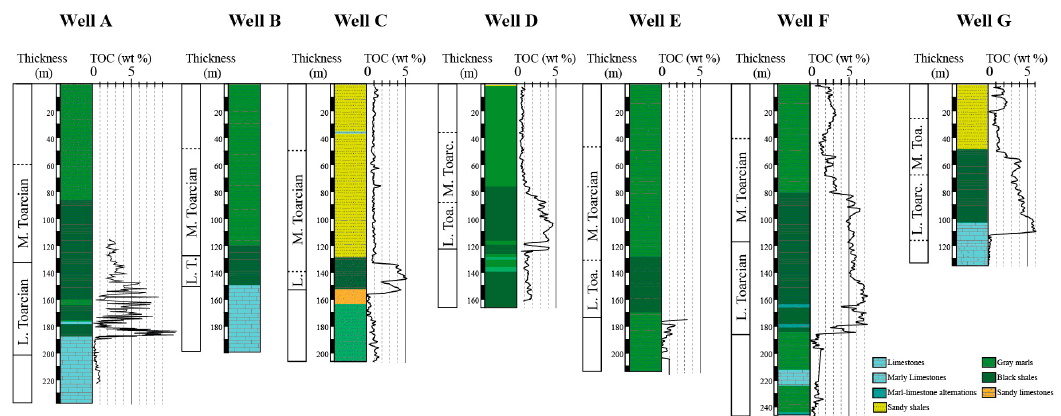
Figure 6. Lithostratigraphic logs and TOC of the seven wells used for the calibration of the stratigraphic model (modified after Bessereau et al. [31]).